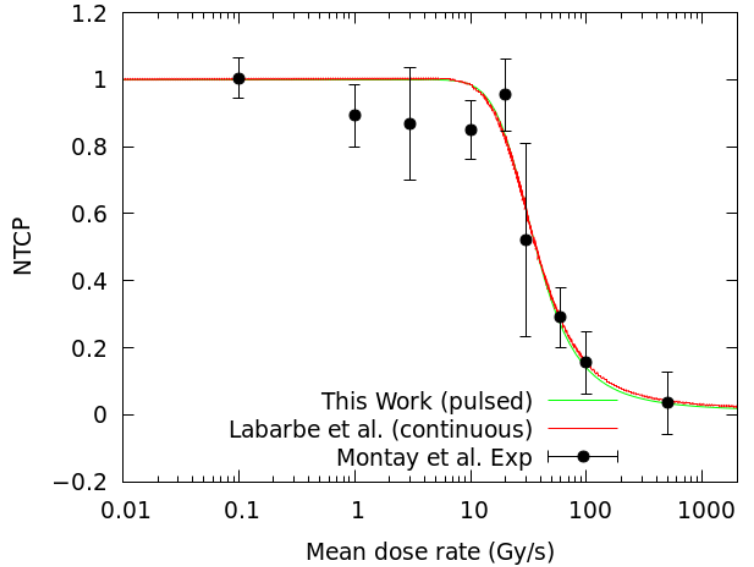
Figure 10. NTCP logistic fit to the experimental data of Montay et al. [45]) for a pulsed (green) beam irradiation using the same physical parameters (frequency and pulse width) of the experiment. The red line represents the same fit obtained in the previous work of Labarbe et al. [32] with a continuous beam (radiation with no time structure).